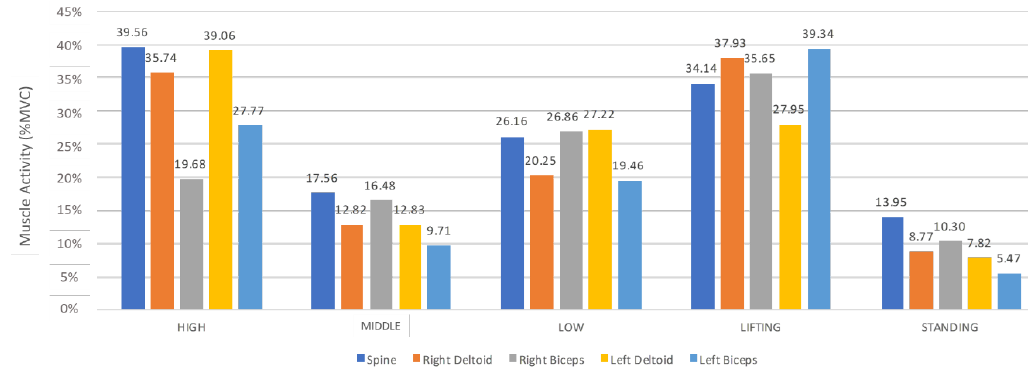
Figure 5. Muscle activity of five body regions by posture.